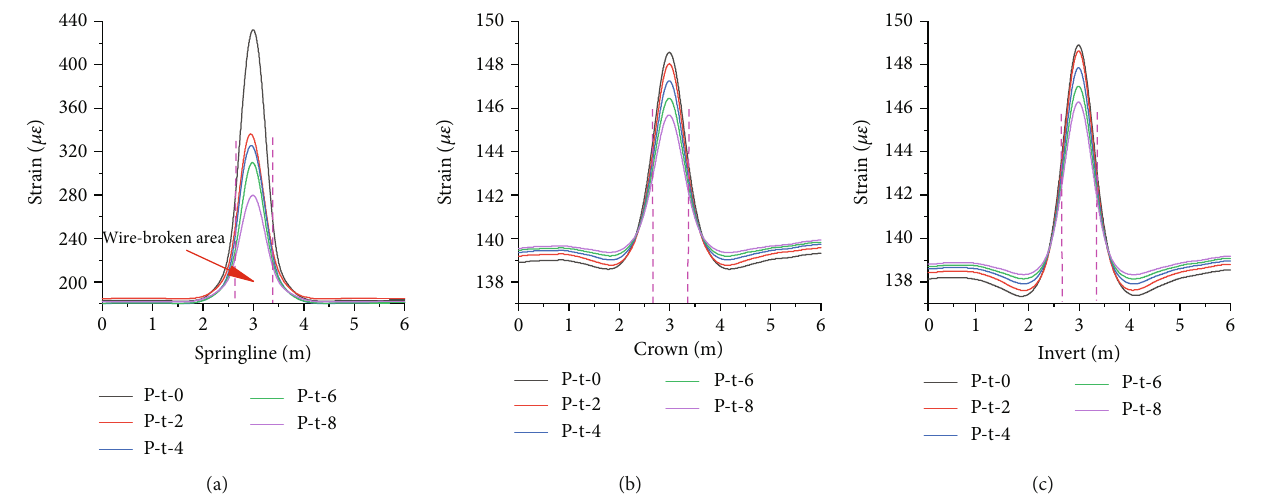
Figure 5: Circumferential strain of the outer concrete core: (a) springline; (b) crown; (c)